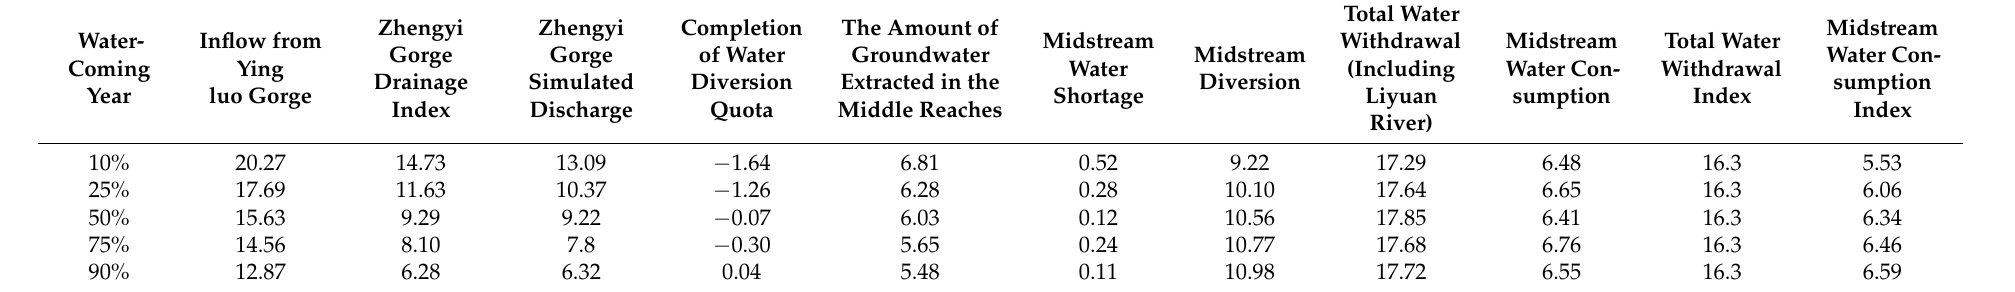
Table 6. Under the condition of current water demand, the allocation results of midstream water resources controlled by water consumption index were not considered, 10 8 m 3 .